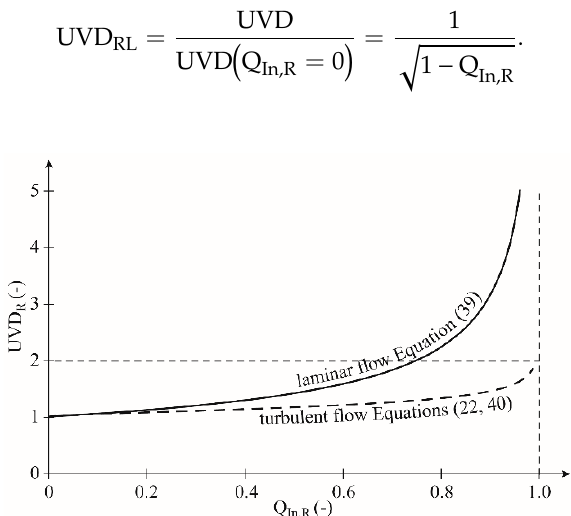
Figure 6. The relation between the relative radiation dose and integral relative discharge in the inflow and outflow.